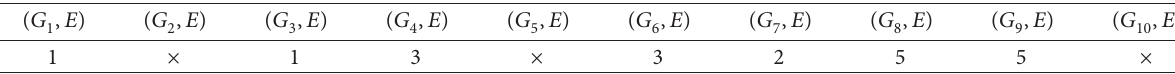
, E ) : i � 1, 2, ... , 10 with respect to attribute a i